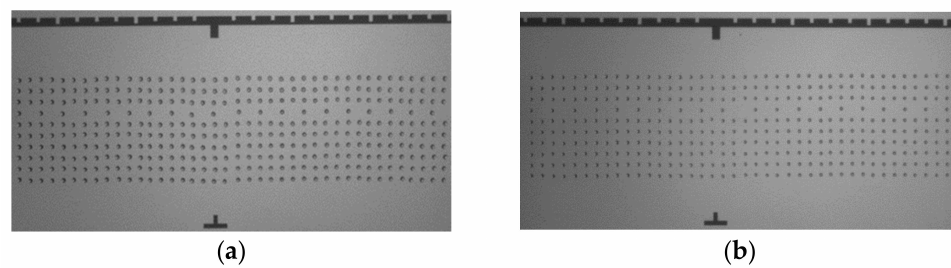
Figure 2. Optical image of HDMA-BG printed on LoC detection area using disodium hydrogen phosphate printing buffer (pH value 9.2) at concentration 120 mg/mL ( a ) and 50 mg/mL ( b ). Passivation